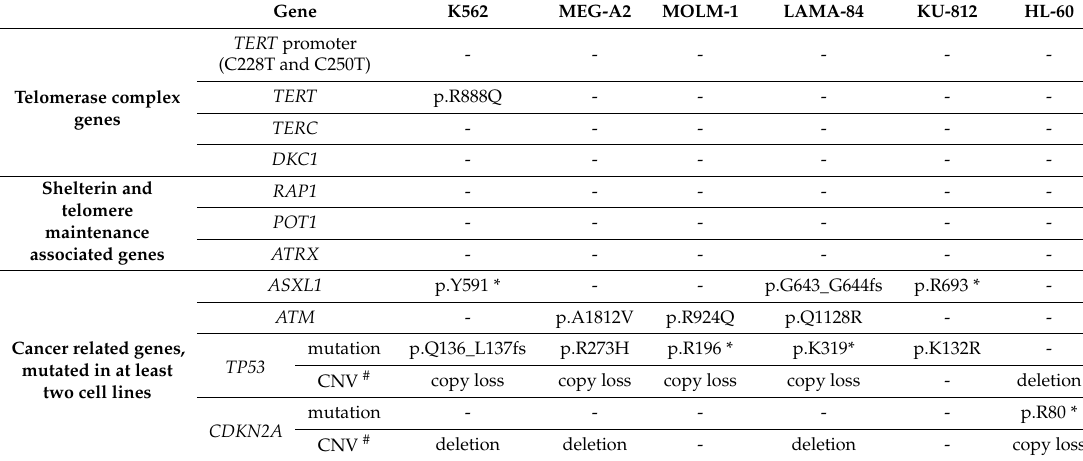
Table 1. Mutational status of selected genes in BCR / ABL1 positive cell lines and HL-60 as determined by targeted enrichment and next-generation sequencing. Analysis of TERT promoter hotspot mutations was confirmed by Sanger sequencing. CNV is additionally given for TP53 and CDKN2A . # copy loss corresponds to the loss of one allele while deletion to loss of both alleles (in HL-60 cell line manual inspection in IGV software of TP53 exons revealed exons 1, 5 and 6). * describes nonsense variant in protein coding. Gene